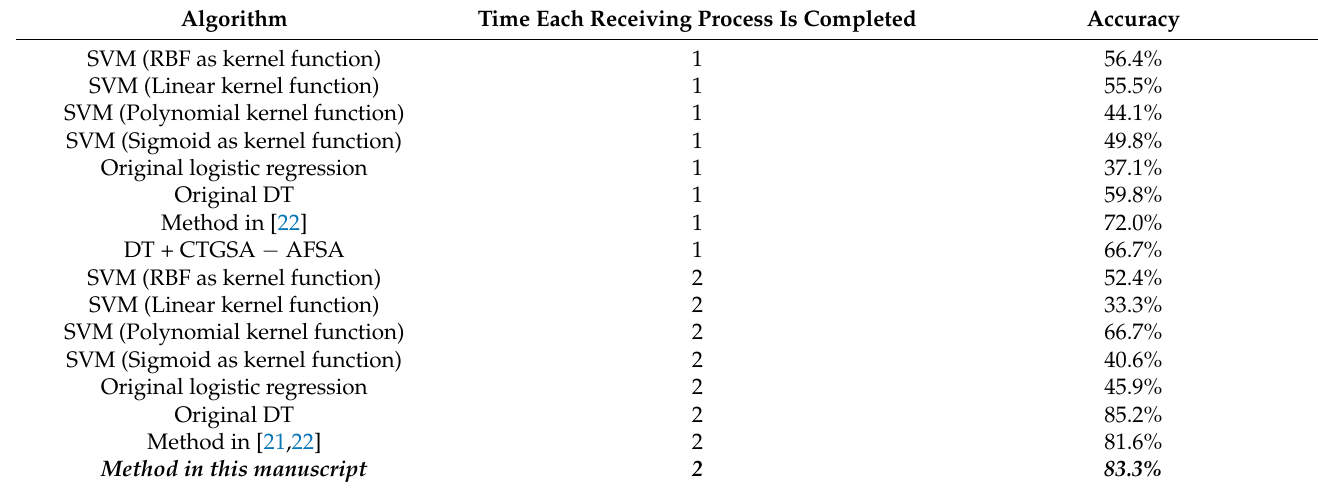
Table 3. Accuracy comparisons of each method under dynamic NLOS